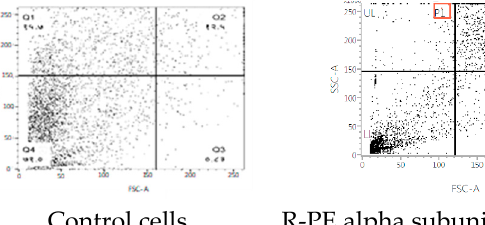
Figure 6. Cytotoxicity of R-phycoerythrin alpha subunit from Pyropia yezoensis analyzed in HepG2 cells. One-way ANOVA was performed to understand the significant difference between the control group and the R-PE alpha subunit-treated groups. The R-PE alpha subunit treated groups (20, 25, and 30 µ g/mL) showed significance activity, ** indicates ( p < 0.01).